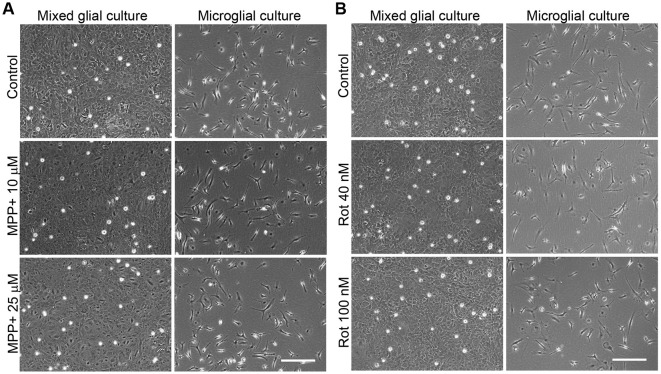
Phase contrast images of the MPP+- and rotenone-treated primary glial cultures. Images show the appearance of the mixed glial cultures and microglial cultures treated for 24 h with 10 and 25 μM MPP+ (A) or 40 and 100 nM rotenone (Rot; B), the working concentrations used in further studies. Bar = 200 μm.